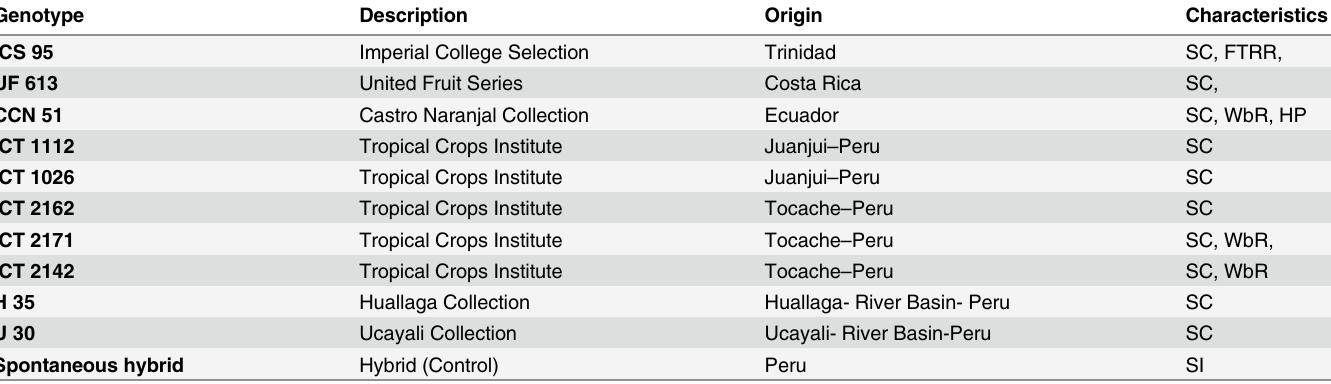
Table 3. Cacao Genotypes and Spontaneous Hybrid Selected for Evaluation of their Impact on Soil Physical and Chemical Properties under Long Term Cacao Agroforestry Management Systems (ITAS, INAS).